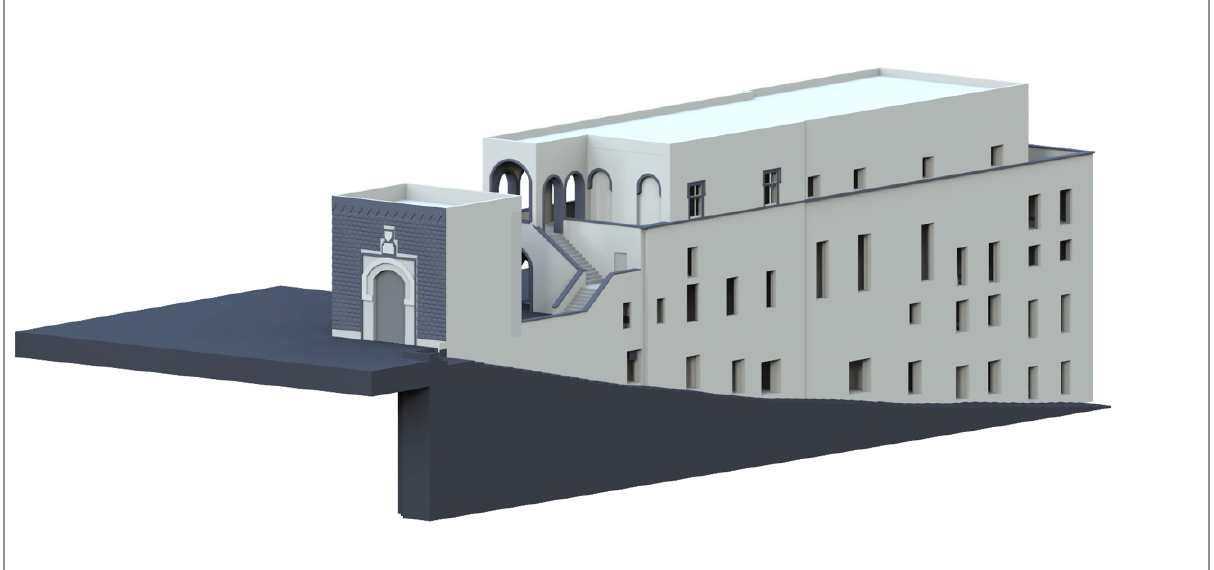
Figure 9. Palazzo Penne, reconstruction of the original configuration on Pendino alley. Modeling by S.